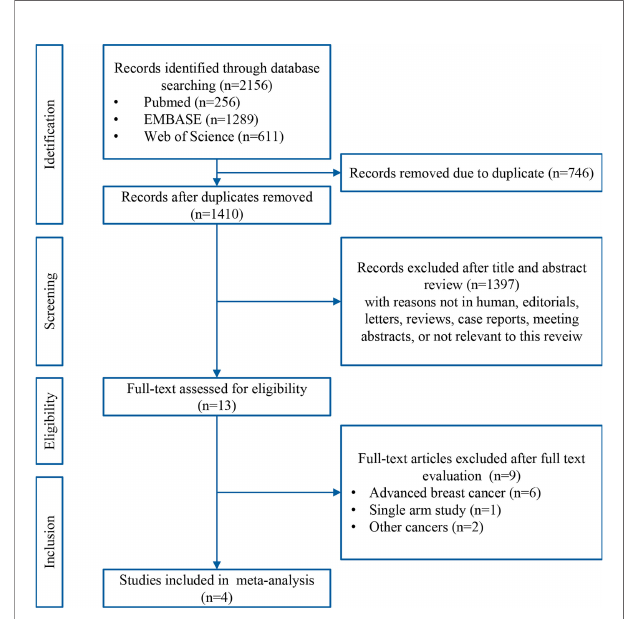
FIGURE 1 | Flow chart of the literature search and study